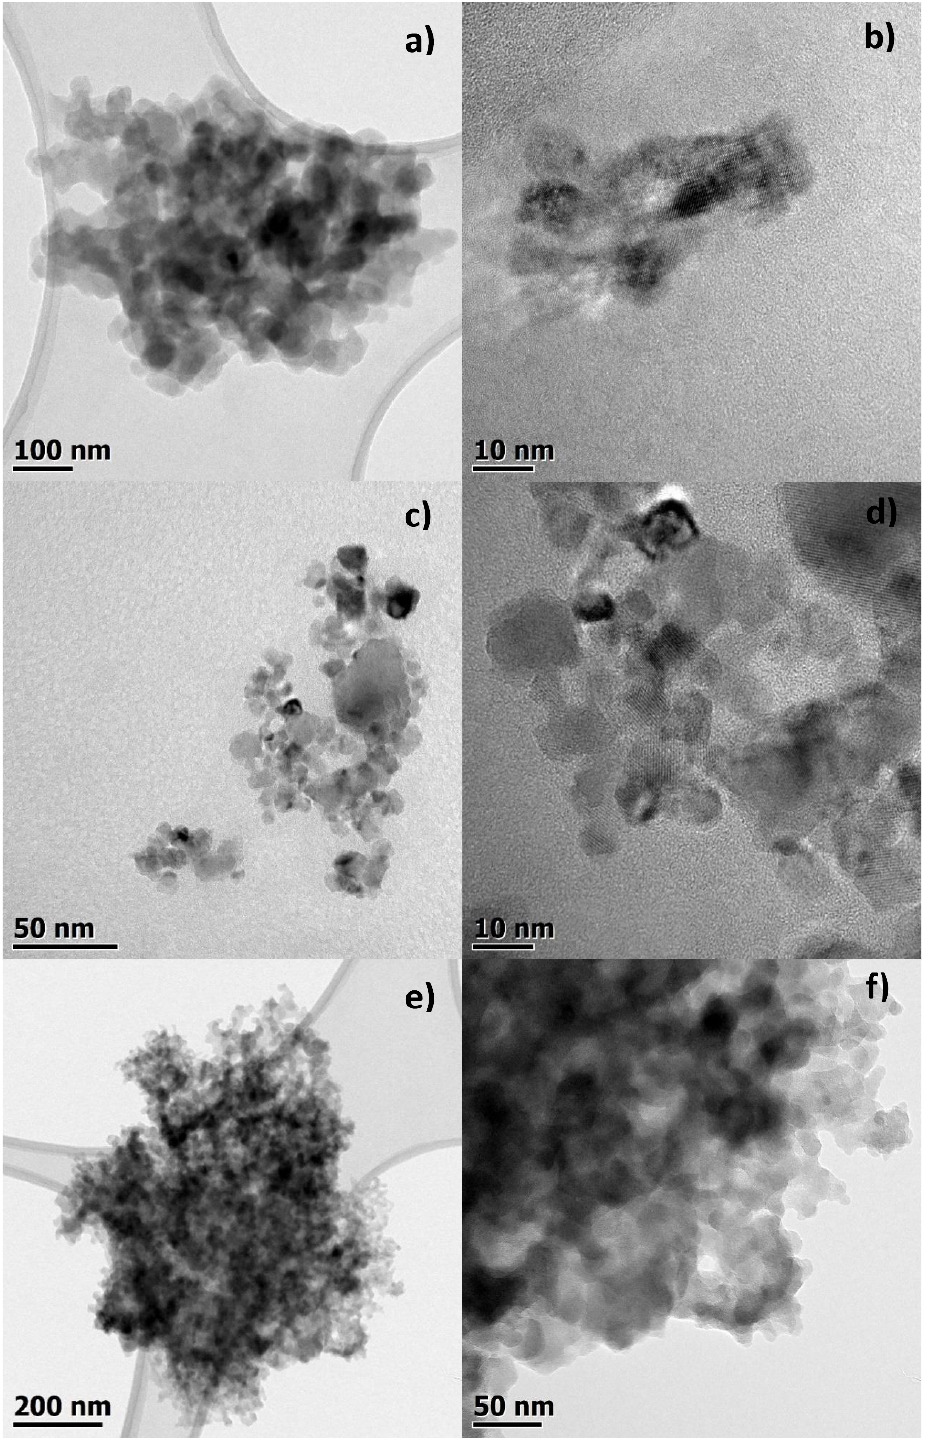
Figure 3. TEM images of Krakow winter dust ( a , b ), Krakow summer dust ( c , d ), NIST PM ( e , f ), respectively.